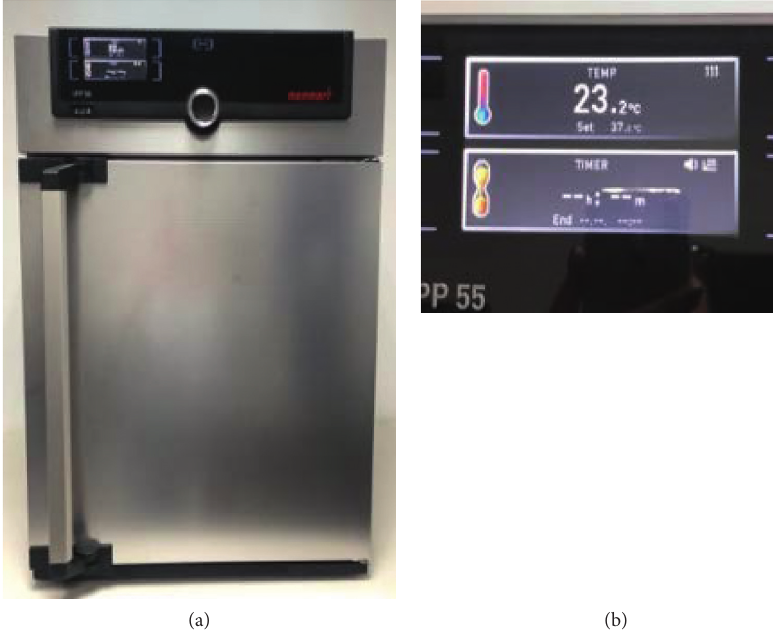
Figure 5: Memmert ® glasshouse (a) at 37 ° C (b).